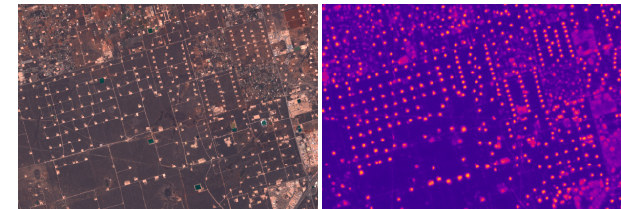
Figure C2. CNN model example, showing Sentinel-2 imagery (left; ESA, 2020) and model output heatmap over the same area (right).